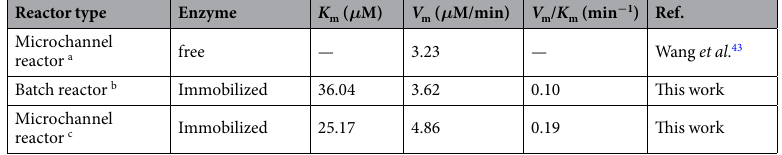
Table 4. Kinetic constants of free and graphene immobilized naringinase in different reactors. a: Reaction condition: rutin concentration 1 g/L, reaction temperature 40 °C, flow rate 2 μ L/min for 40 min, [Bmim][BF 4 ]- buffer (pH 9.0) (10/90, v/v) as the reaction medium; b: Reaction condition: rutin concentration 0.1 g/L, reaction temperature 50 °C, 120 r/min in an incubator shaker, reaction time 1 h, graphene immobilized naringinase was suspended in a reaction system; c: Reaction condition: rutin concentration 0.05 g/L, reaction temperature 40 °C, flow rate 4 μ L/min, reaction time 20 min, functionalization form of graphene immobilized naringinase flowed into a microchannel reaction